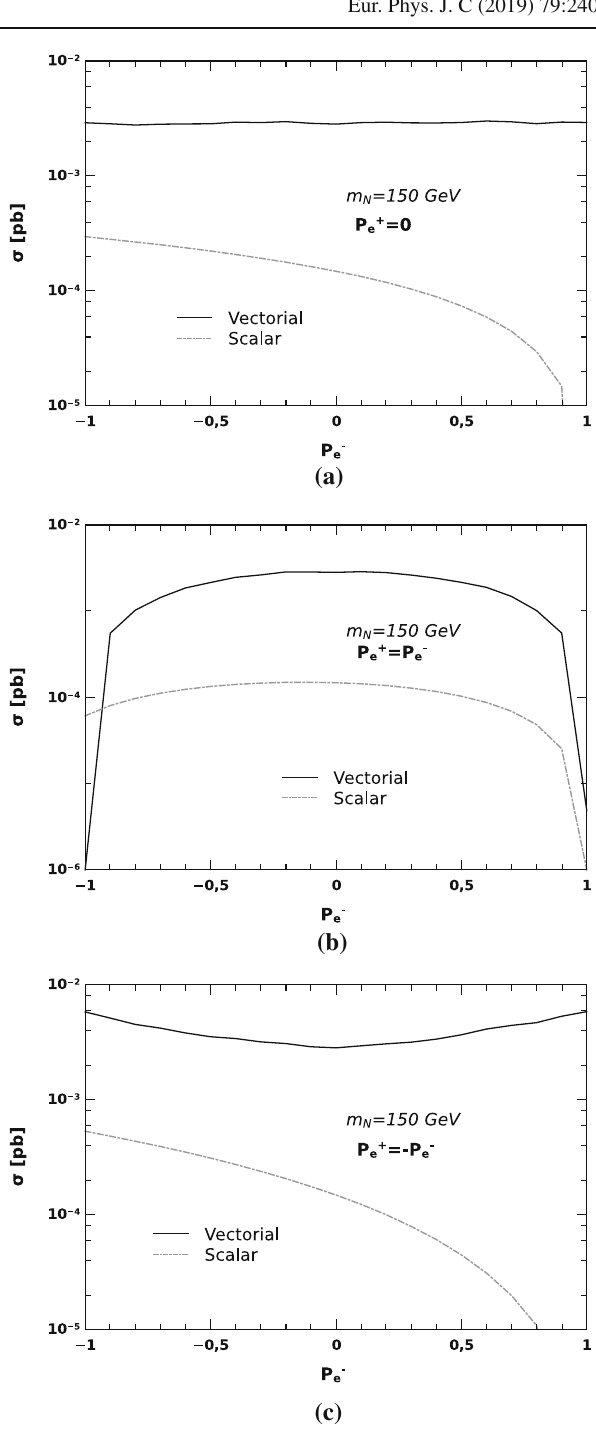
Fig. 6 Signal cross section as a function of the initial electron polar- ization